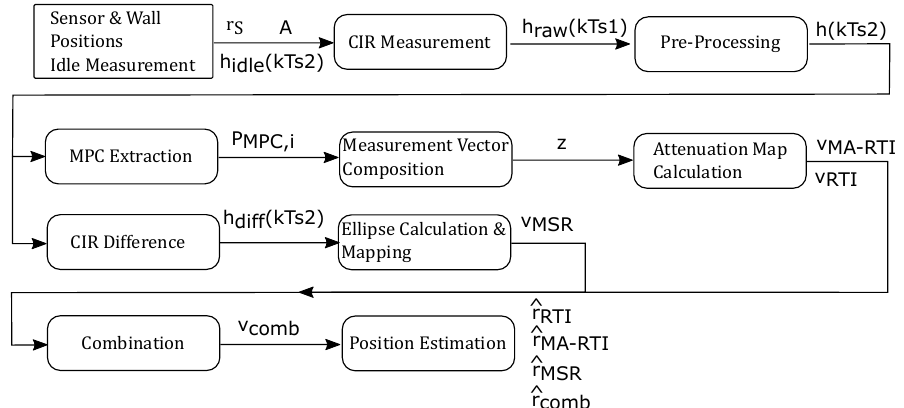
Figure 10. Flow chart of the proposed